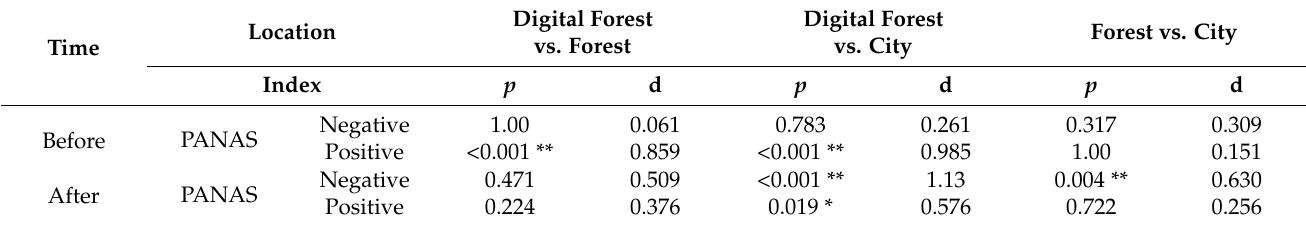
Table 10. Analysis results of PANAS in three settings (multiple